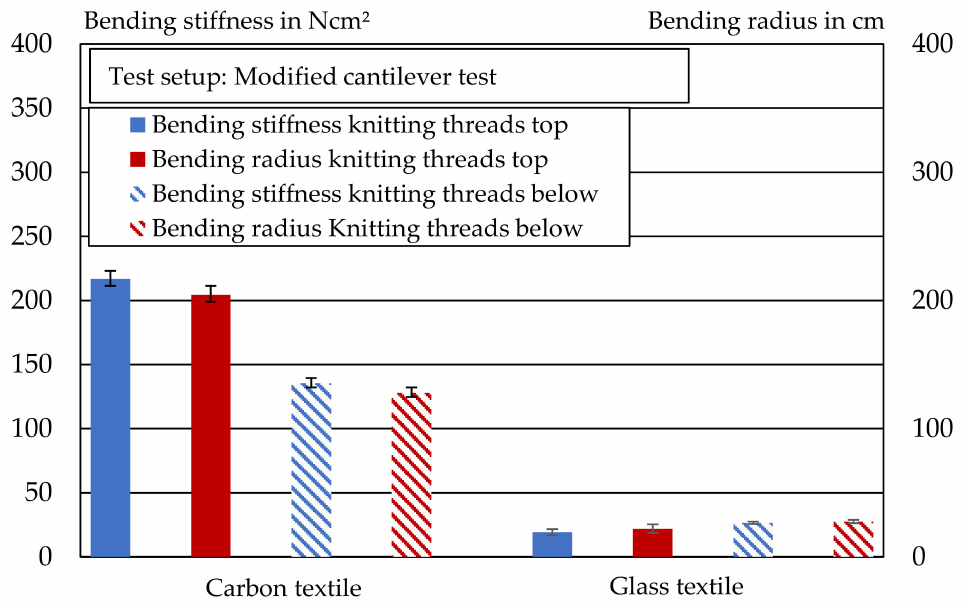
Figure 7. Bending stiffness and bending radius of the carbon and glass fibre textiles depending on the orientation of the knitting